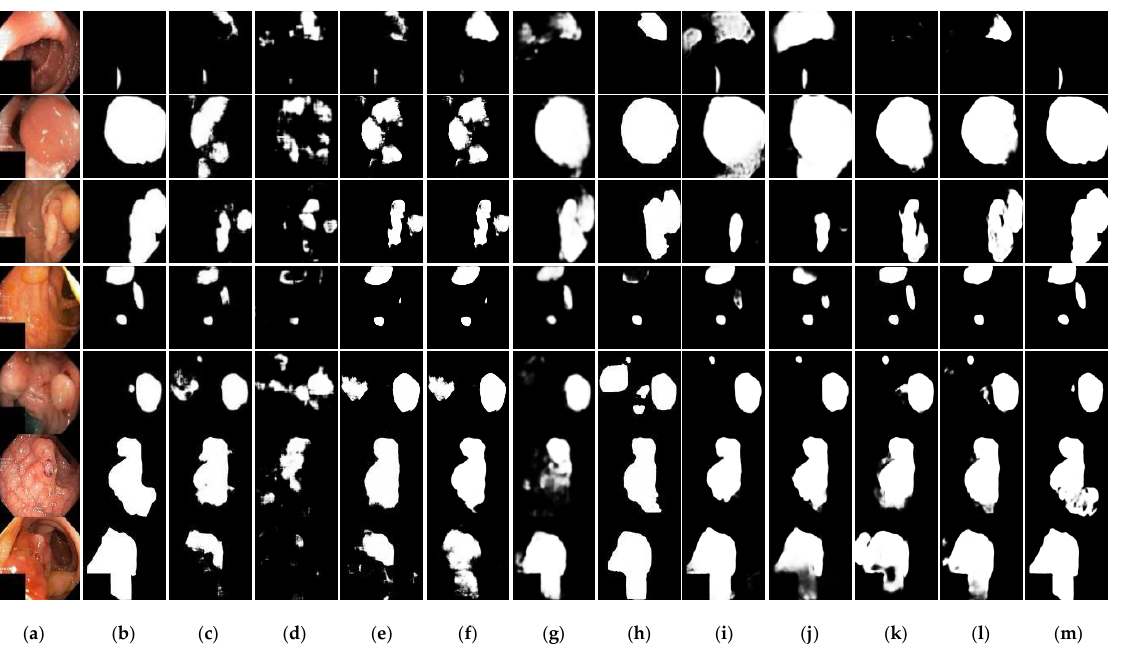
Figure 5. Comparison of qualitative results from the Kvasir-SEG dataset. ( a ) image. ( b ) mask. ( c ) Unet. ( d ) ResUNet. ( e ) UNet++. ( f ) ResUNet++. ( g ) PSPNet. ( h ) Mask R-CNN ( i ) PraNet. ( j ) Polyp- PVT. ( k ) CaraNet. ( l ) SSFormer-L. ( m )